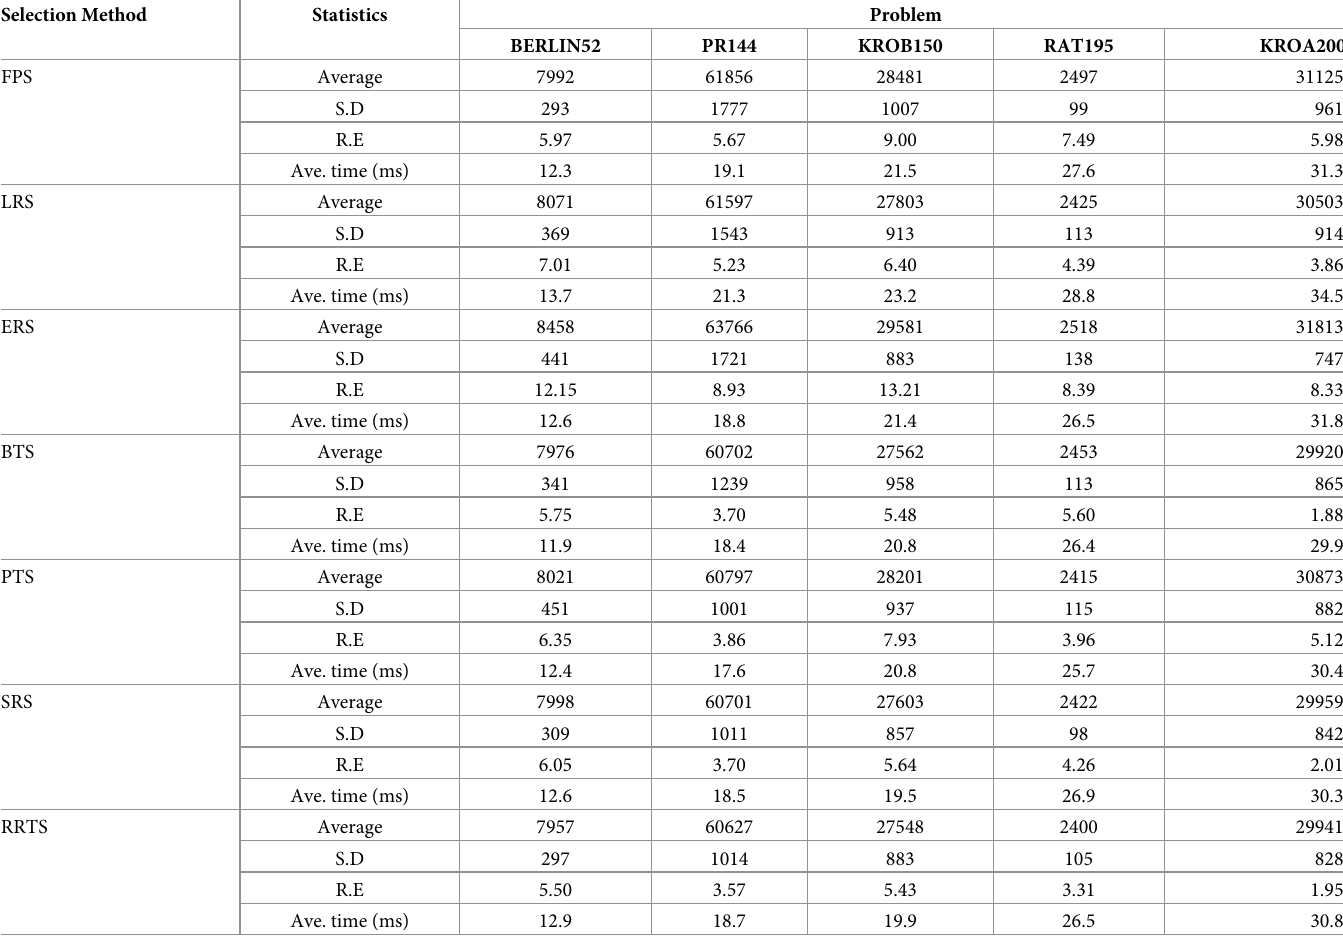
Table 6. Results of various selection methods with respect to OX (crossover) and EM (mutation) operators. Selection Method